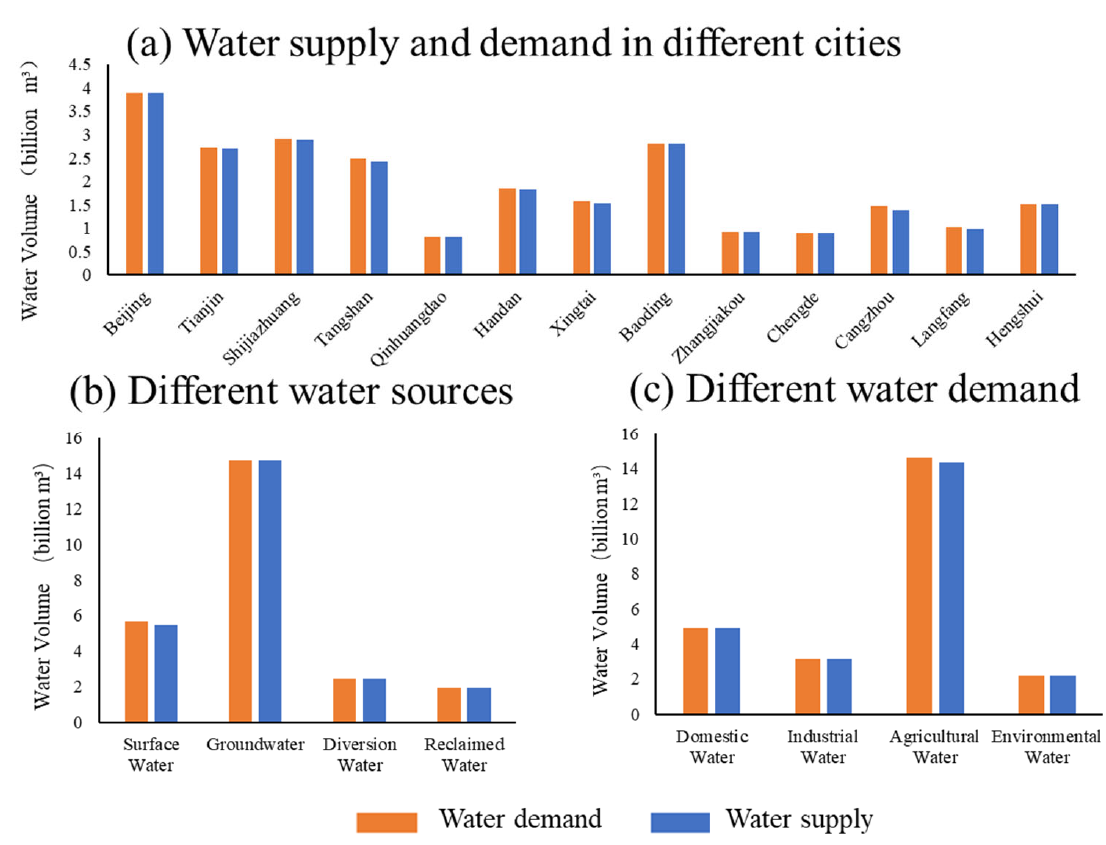
Figure 8. Comparison of water supply and water demand.